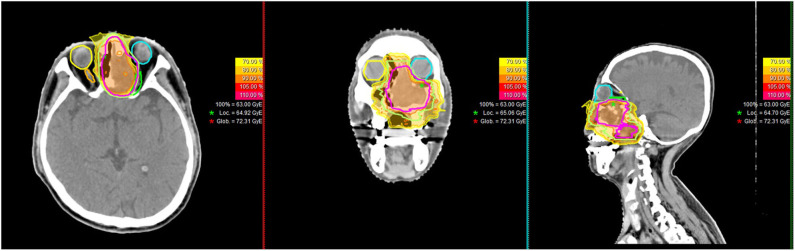
A typical treatment plan of a patient with soft-tissue sarcoma of the skull base.